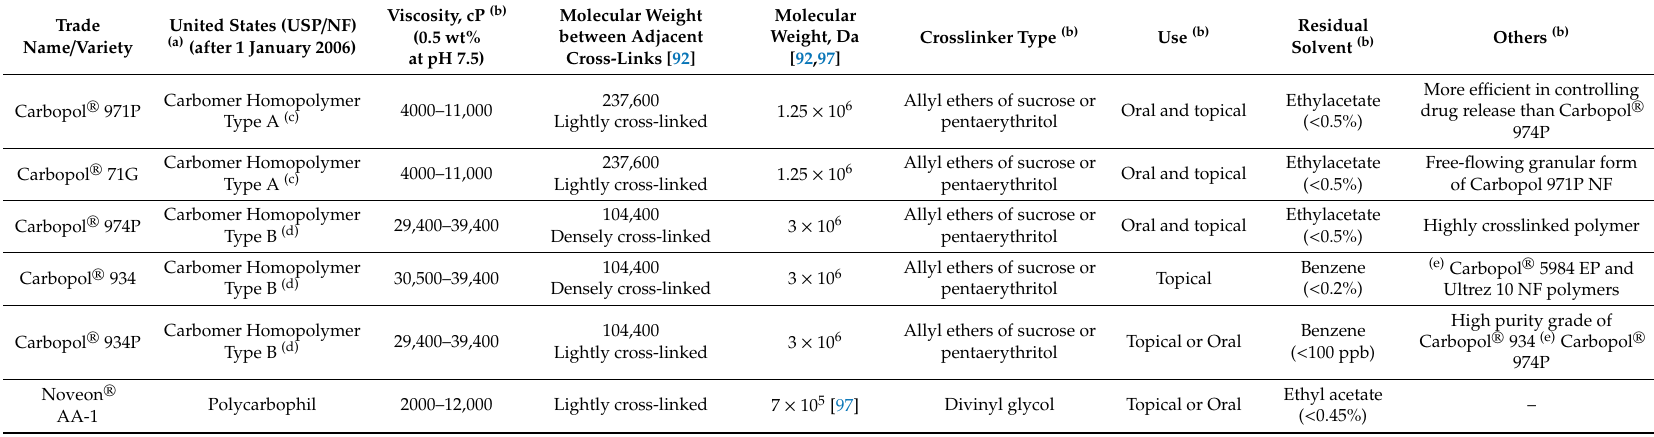
Table 4. Chemical composition and properties of selected polycarbophil and Carbopol